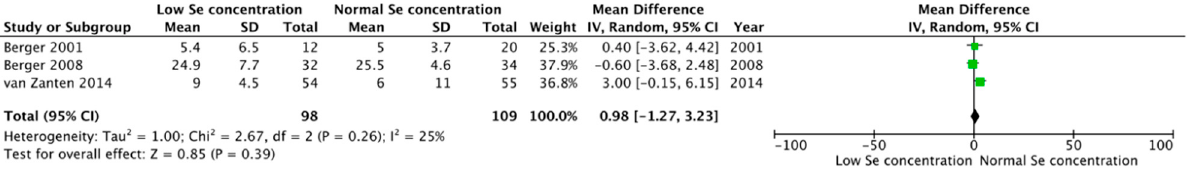
Figure 7. Forest plot of the impact of low serum Se concentration on the length of ventilator usage in patients with severe trauma.